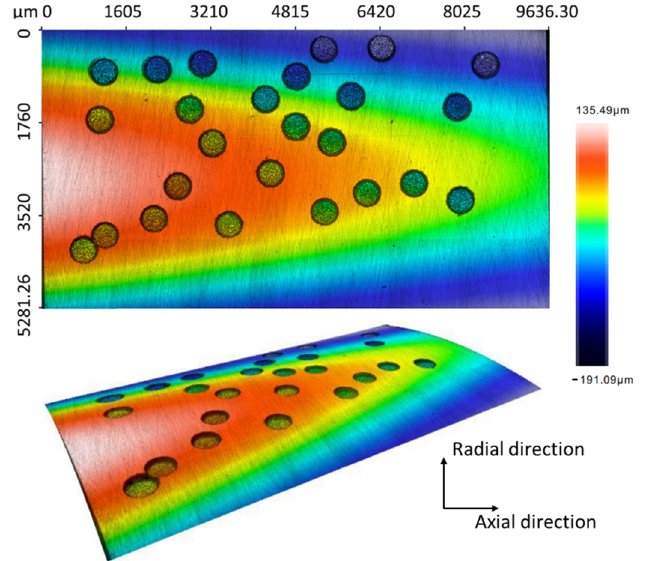
Figure 9. Random pittings generated by micro-EDM on the bearing’s outer ring. Measurement was performed by Sensofar S Neox, with an objective of 20×, restoration applied and no filtration applied.